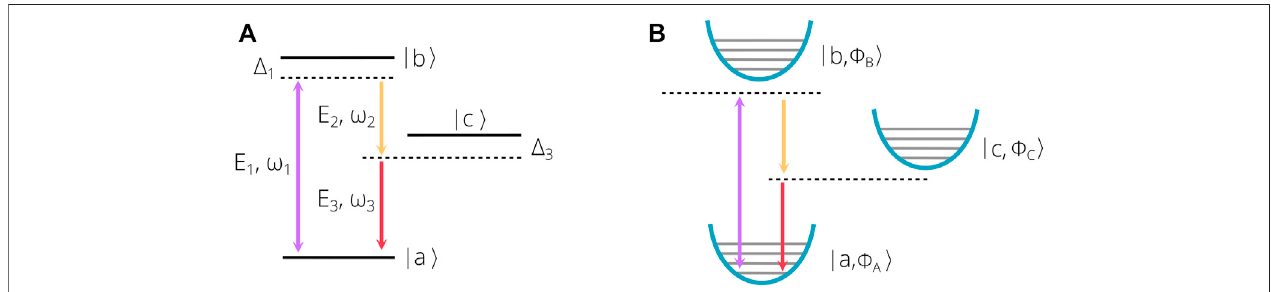
FIGURE1 |(A) Athree-levelatom mediates the interactionbetweendifferentwaves. Itisconsidered tobe excited via a quadrupole transition connectinglevels | a 〉 and | b 〉 and decays through cascade dipole transitions along level | c 〉 . (B) Since the atomic system is trapped in a region comparable to the involved radiative wavelengths, vibrational motion effects must be